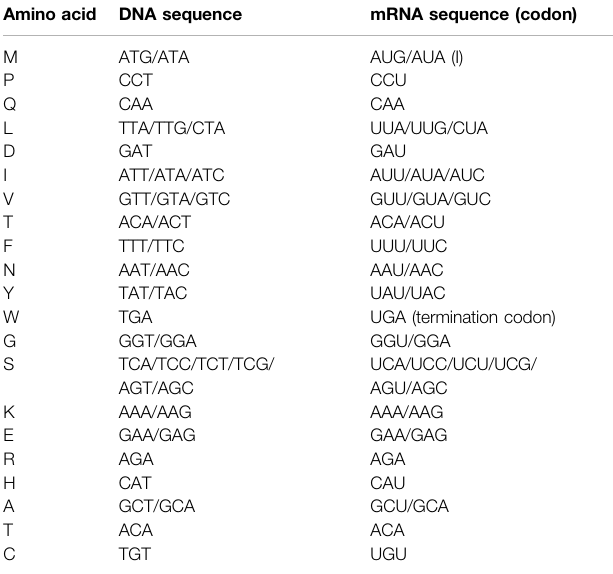
TABLE 4 | The nucleotide sequence of 21 amino acids in Nemopilema nomurai . Amino acid DNA sequence mRNA sequence